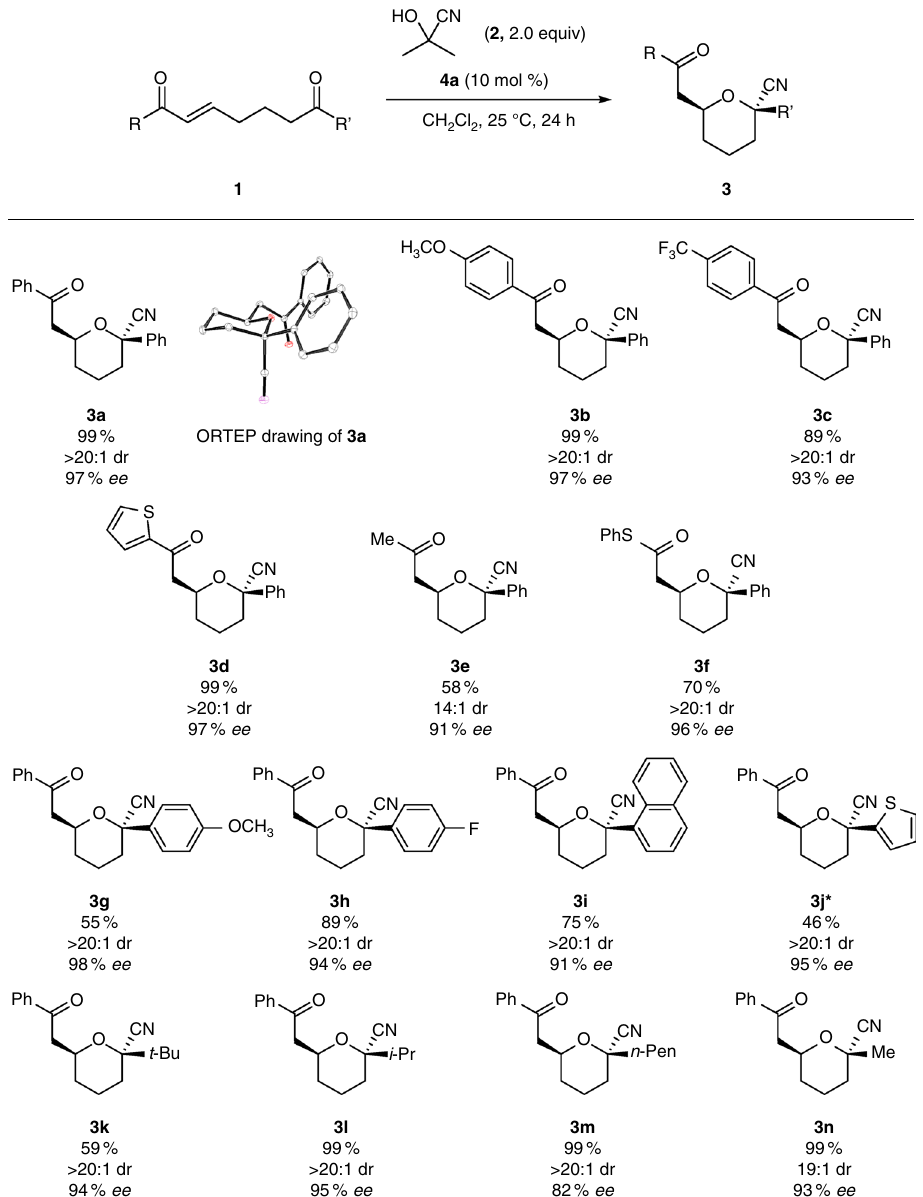
Fig. 3 Substrate scope. Reactions were run using 1 (0.15 mmol), 2 (0.30 mmol), and 4a (0.015 mmol) in CH 2 Cl 2 (0.30 ml). Yields represent material isolated after silica gel column chromatography. Diastereomeric ratios (dr) were determined by 1 H NMR spectroscopy. *Reaction was run for 72 h